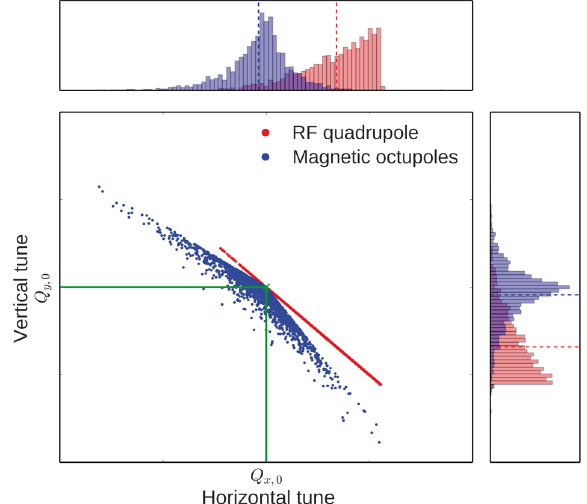
FIG. 4. Comparison of incoherent betatron tune distributions in the ð Q x ; Q y Þ -space introduced by magnetic octupoles (blue) powered in a two-family scheme with negative (positive) polarity in the focusing (defocusing) family, and a single rf quadrupole (red). The lines and the cross in green mark the bare machine tunes ð Q x; 0 ; Q y; 0 Þ . Histograms on the top and on the side show the projections of the tune distributions onto the Q x - and the Q y -axis respectively.